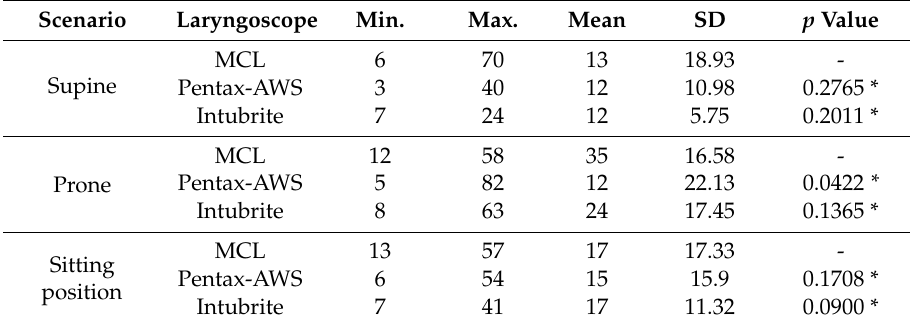
Figure 5. Time of intubation with all devices in different positions of the manikin [s]. Table 2. Time to successful intubation in simulated different positions [s] (Min ‐ minimum, Max-maximum, SD-standard deviation). MCL-Macintosh Laryngoscope, * p value when compared with the MCL (control group).